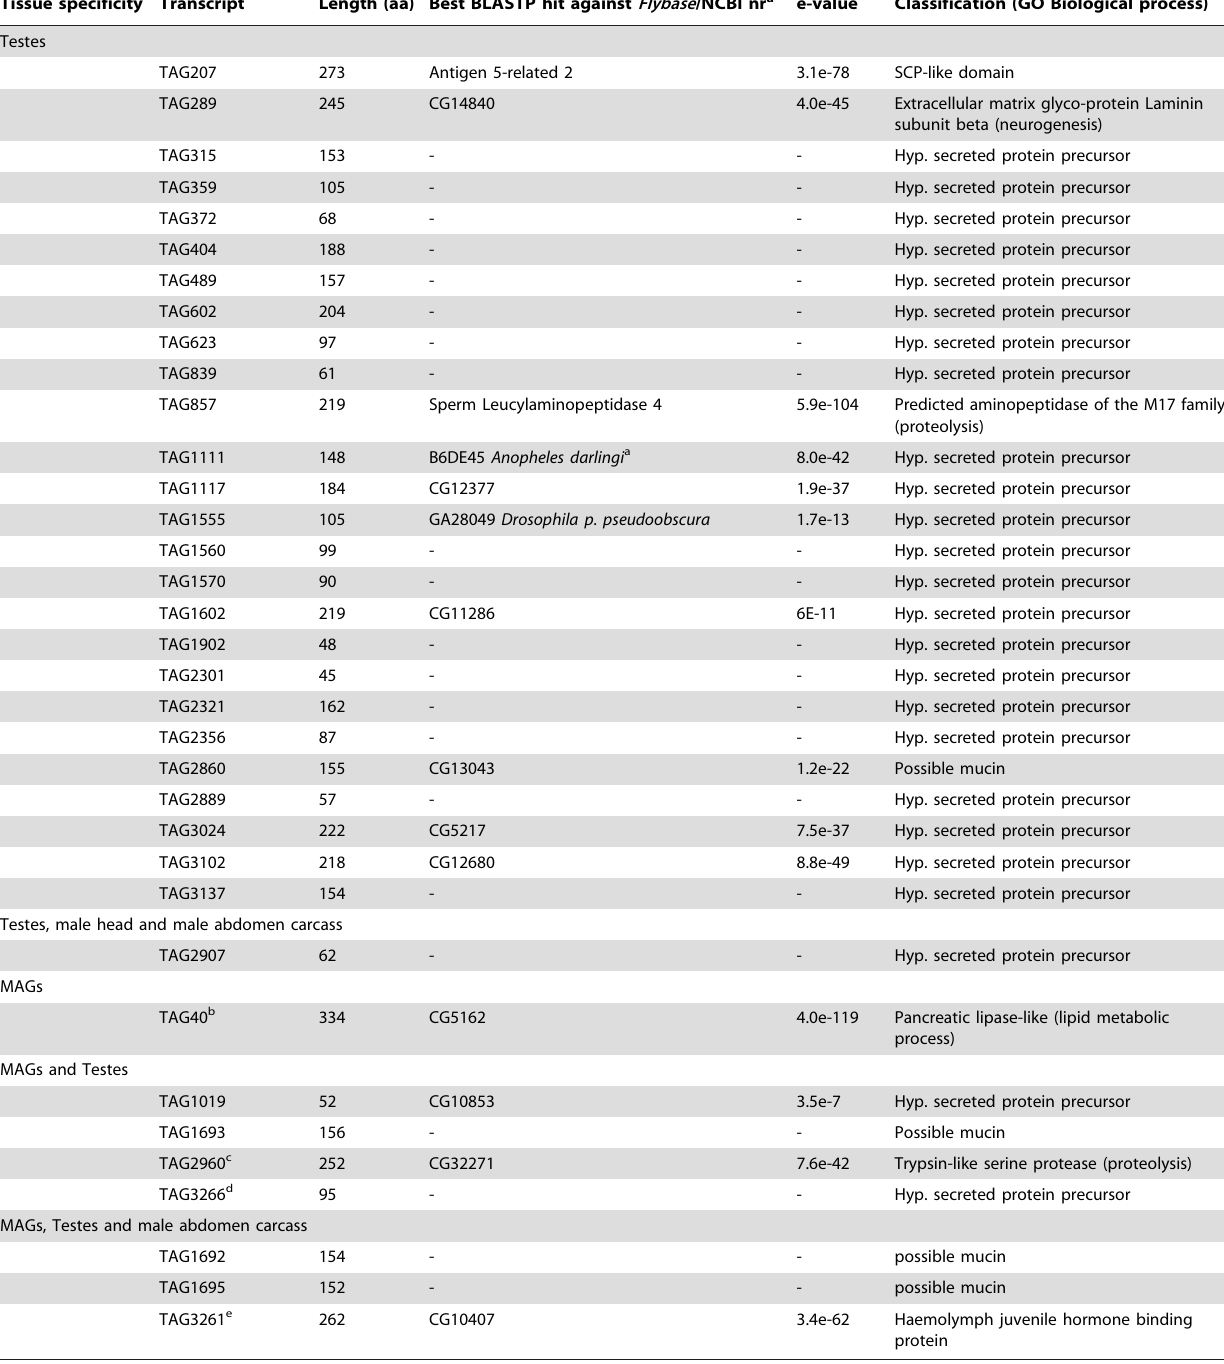
Tissue specificity